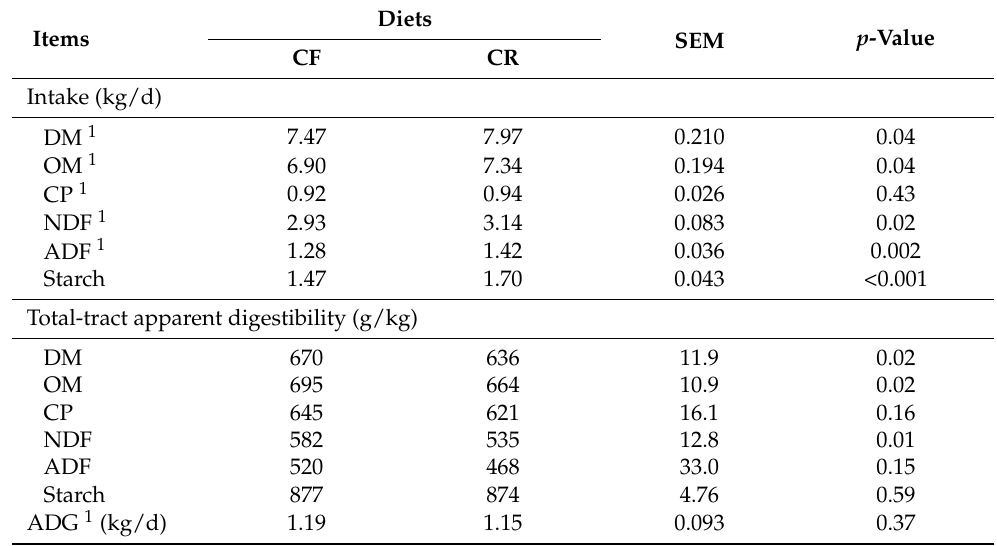
Table 5. Feed intake and digestibility and growth performance in beef cattle fed corn stover after fresh-corn harvested (CF) or corn stover after ripe-corn harvested (CR) silage diet (n =